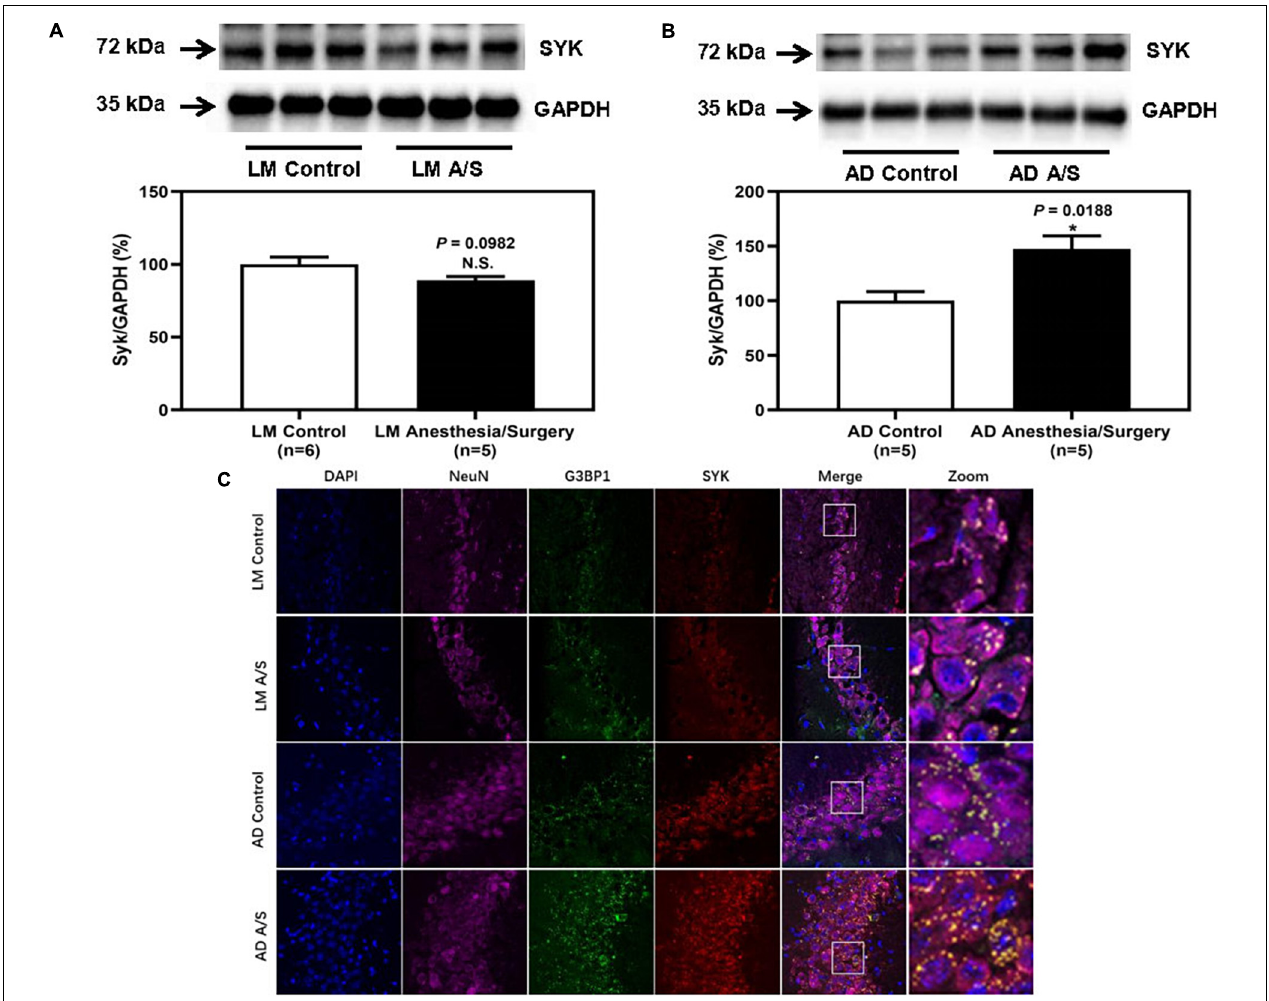
FIGURE 6 | The effect of anesthesia and surgery on the levels of SYK in the hippocampus of LM mice and 5XFAD Tg mice. SYK expression in the hippocampus of postoperative 24 h of LM mice (A) and 5XFAD Tg (B) mice in control and anesthesia/surgery group. (C) Immunostaining of SYK and G3BP1 positive neurons in the hippocampus of LM mice and 5XFAD Tg mice in control and anesthesia/surgery group. The hippocampus level of SYK was significantly increased in 5XFAD Tg mice but not LM mice at postoperative 24 h. The immunostaining of SYK and G3BP1 showed that SYK, G3BP1, and hippocampus neurons (NeuN) were colocalized. Results are expressed as mean ± SEM. Student t -test. N.S., P > 0.05 vs. untreated controls. * P < 0.05 vs. untreated